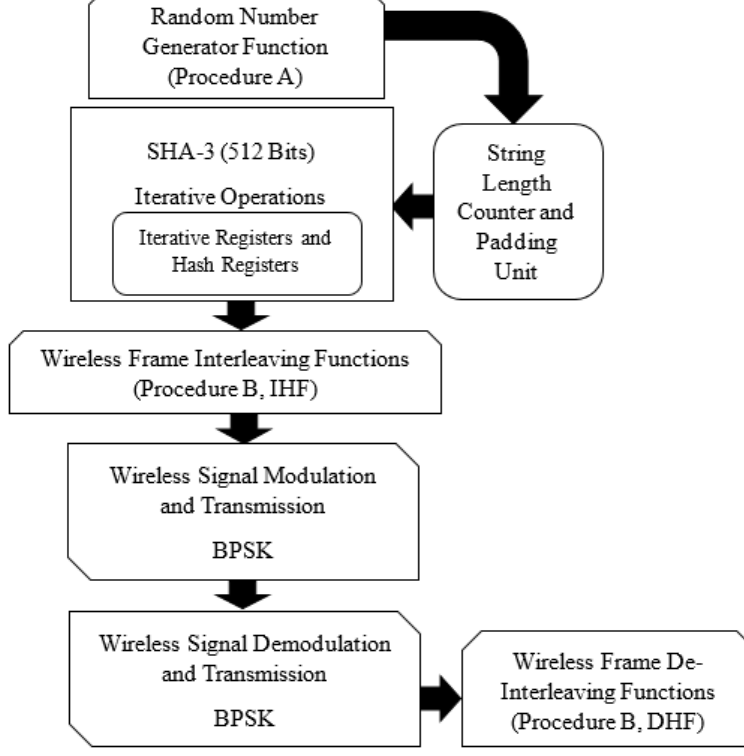
Figure 5. SHA ‐ Based IHF and DHF Functions. Figure 5. SHA-Based IHF and DHF